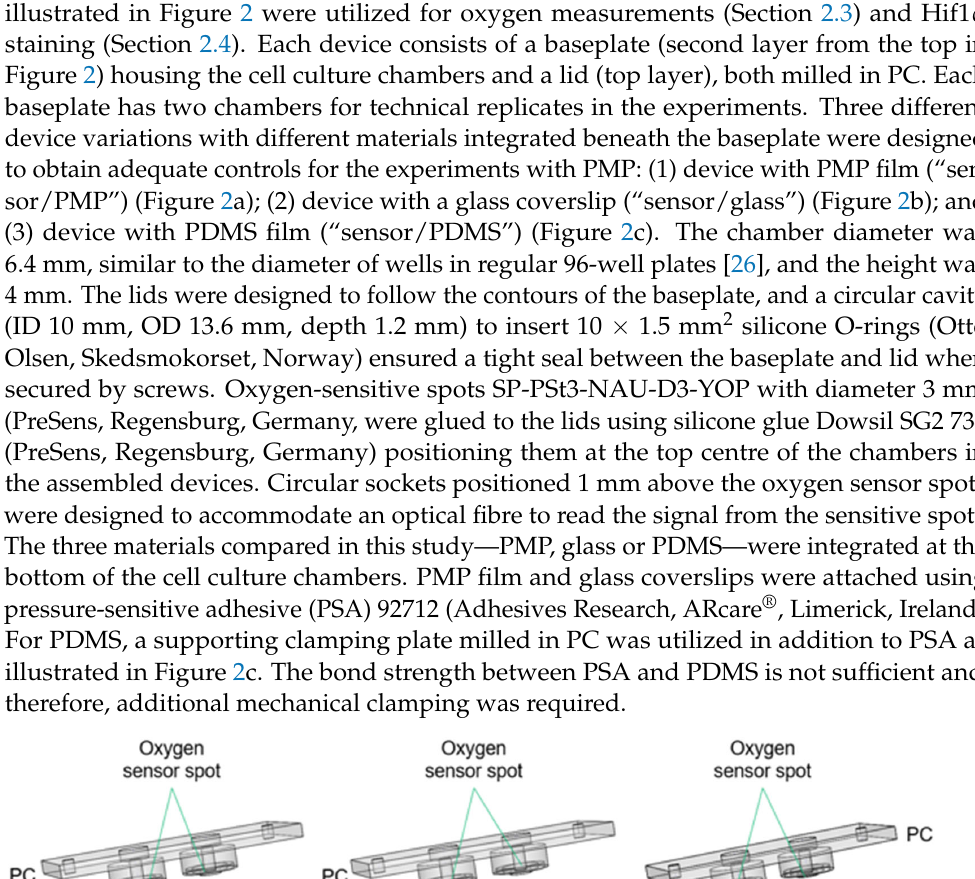
Figure 3. Culture chamber devices without oxygen sensors. Two devices used for the comparison of cell adherence, proliferation and viability (Section 2.5). The only difference from the devices in Figure 2 is in the design of the lids, which are here only support covers to ensure sterility (referred to as “non ‐ sensor lids”). These were designed with either a PMP film ( a ) or a glass coverslip ( b ) for the bottom part of the culture chamber. 2.2.3. Fabrication The baseplates, lids and clamping plates were milled in polycarbonate (Lexan) using a 3 ‐ axis milling machine (DMG DMC 1035 V, 10,000 rpm, rough/fine milling performed using 3/0.5 mm endmill, 500/300 mm/min feed rate, 3/0.05 mm axial depth of cut and 0.8/0.2 mm radial depth of cut). The milled parts were wiped with isopropanol, rinsed in DI water and ultrasonicated in DI water for 5 min. The oxygen sensitive spots were then glued to the lids and left to dry for 24 h at room temperature. Then, 18 sensors were char ‐ acterized in air, finding a mean oxygen concentration of 21.5% with standard deviation of 0.03%. Commercial PMP film ME31110 (Goodfellow, Huntingdon, UK) with thickness 0.125 mm and grade DX845 was made optically transparent by polishing with diamond